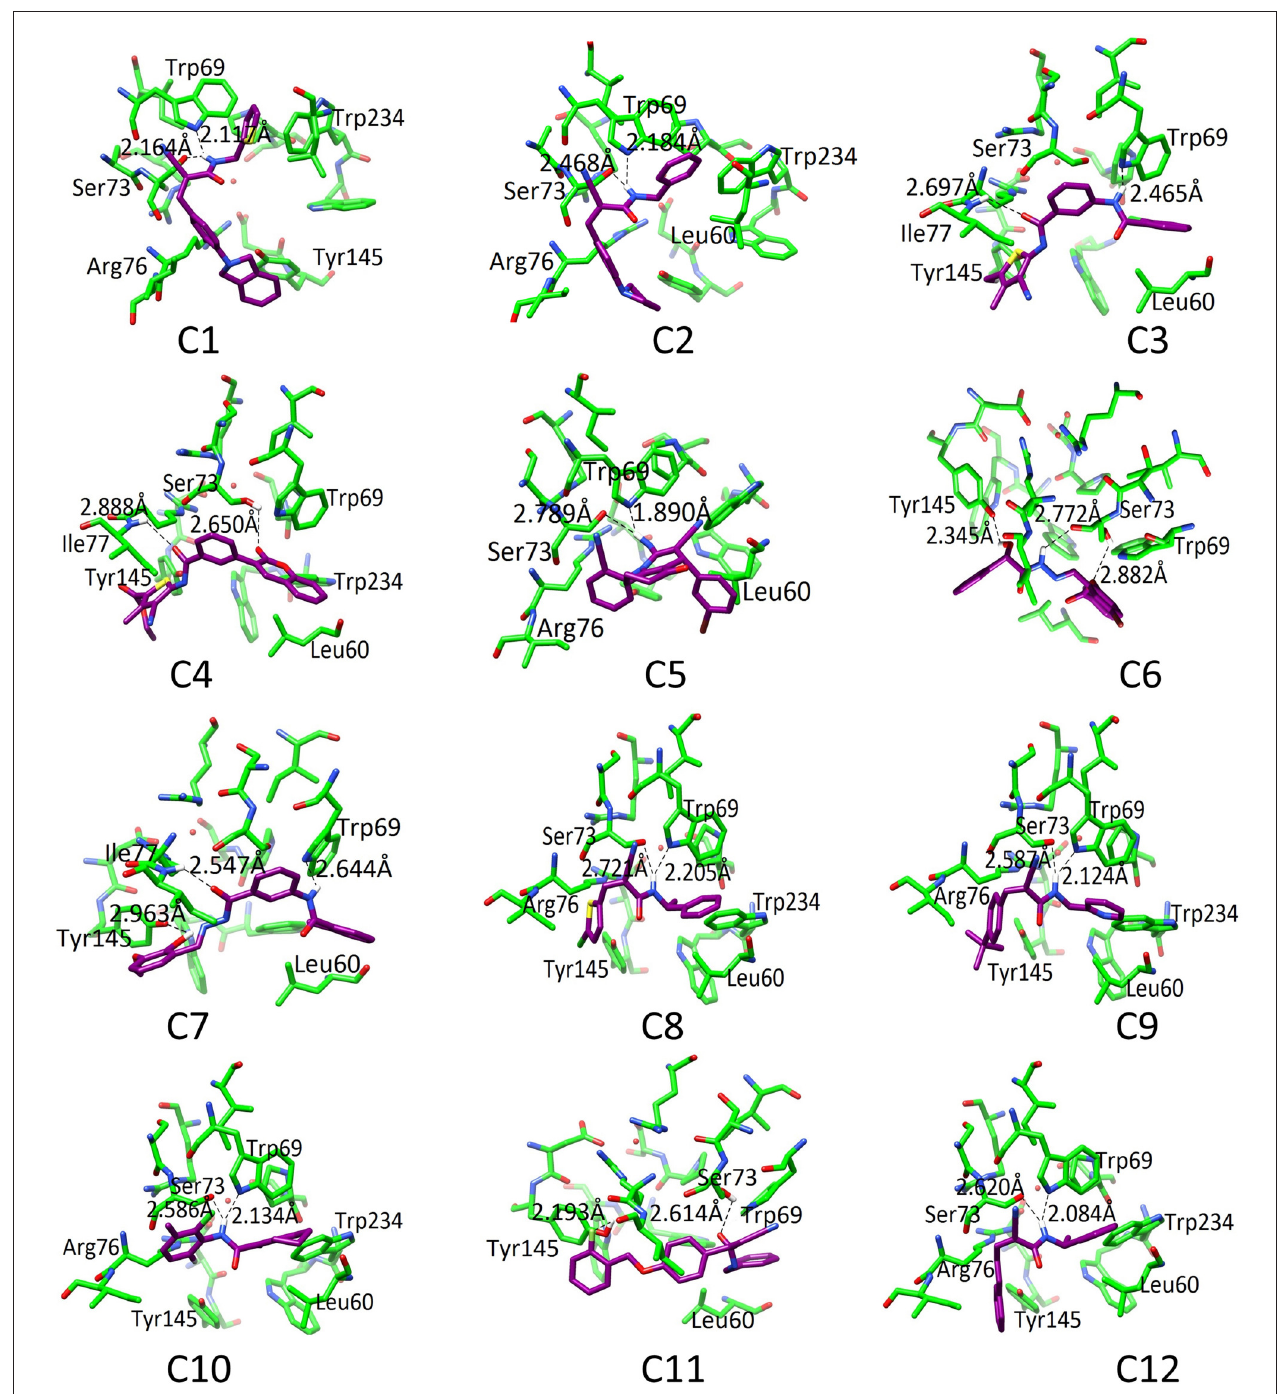
FIGURE 4 | The docked orientation of 12 SDHIs. The interacting residues and the compounds are presented in green and magenta colors, respectively. H-bonds are displayed in black dotted